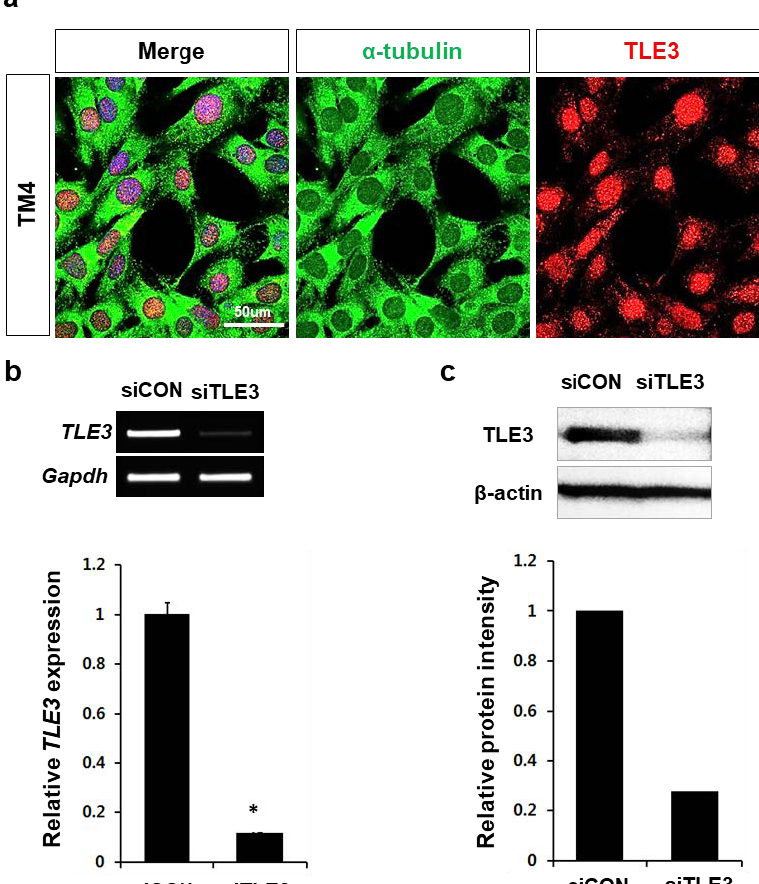
Figure 3. RNAi-mediated knockdown of TLE3 in TM4 cells ( a ) Immunofluorescence analysis of TLE3 in TM4 cells. The alpha-tubulin ( α -tubulin) was used as a staining marker of cytosol. Nuclei were stained by DAPI. Scale bar represents 50 µ m. ( b ) RT-PCR (upper panel) and qRT-PCR (lower panel) analysis of TLE3 in TLE3 - knockdown TM4 cells. TLE3 expression levels were normalized with Gapdh mRNA. Data are represented as mean ± SEM. The Student t -test was applied to calculate p -value. * p < 0.01. ( c ) Western blot analysis (upper panel) of TLE3 in TLE3 - knockdown TM4 cells. β -Actin was used as a loading control. The band intensity was analyzed by Image J software (lower panel).